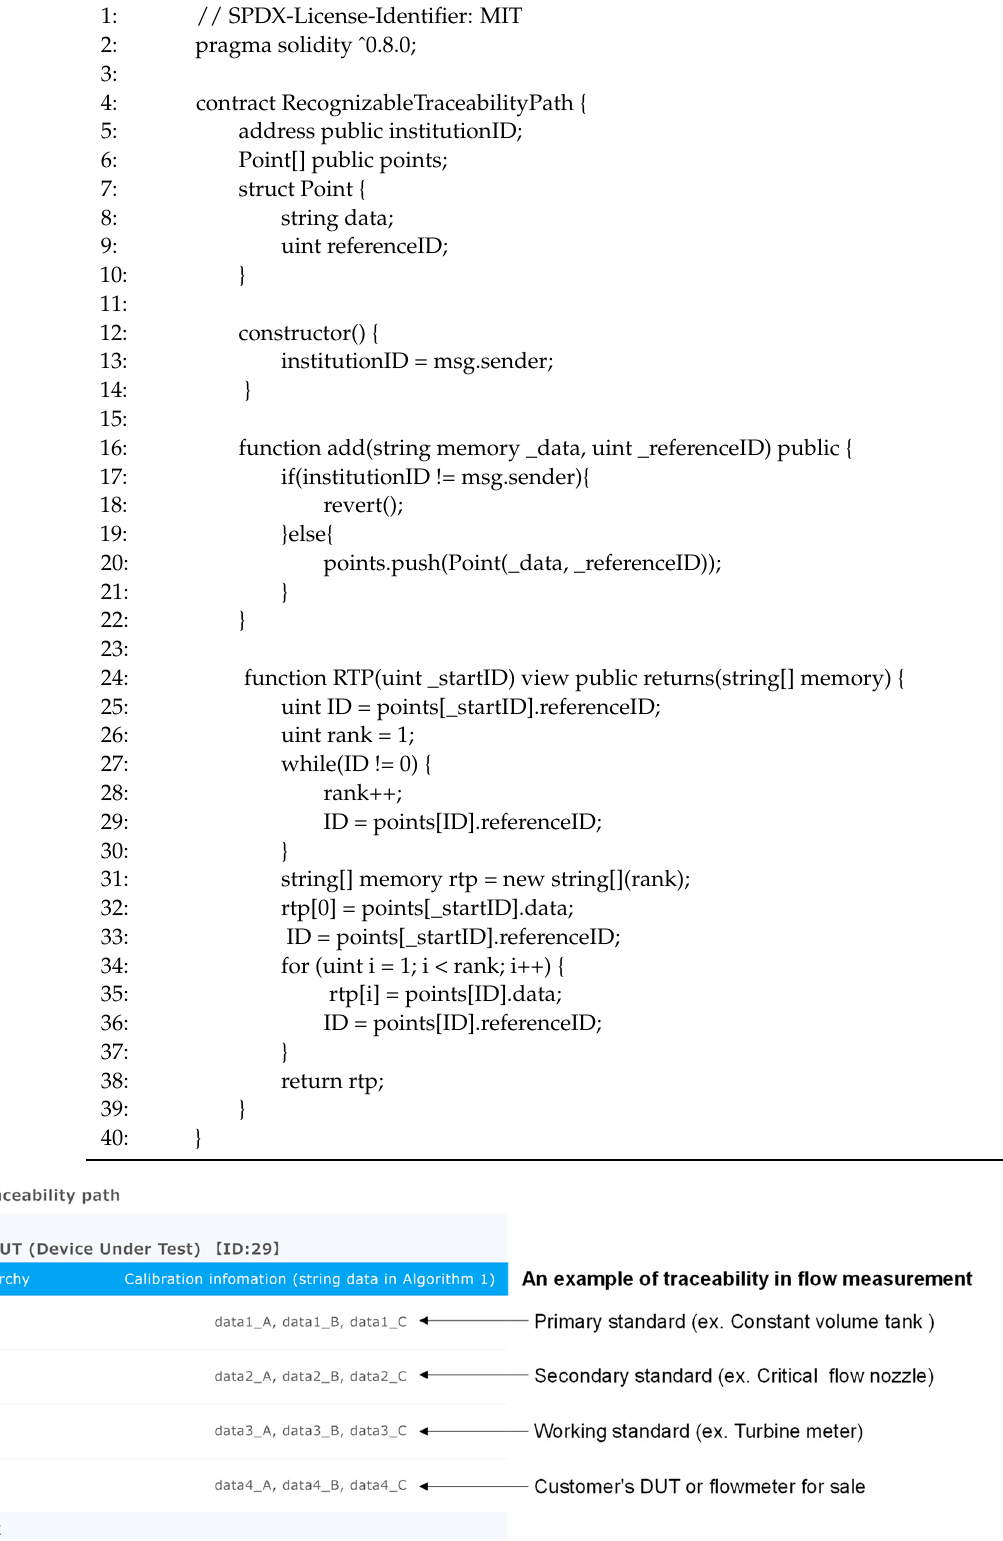
Algorithm 1: Smart contract on the recognizable traceability path (RTP) written using Solidity in this study.